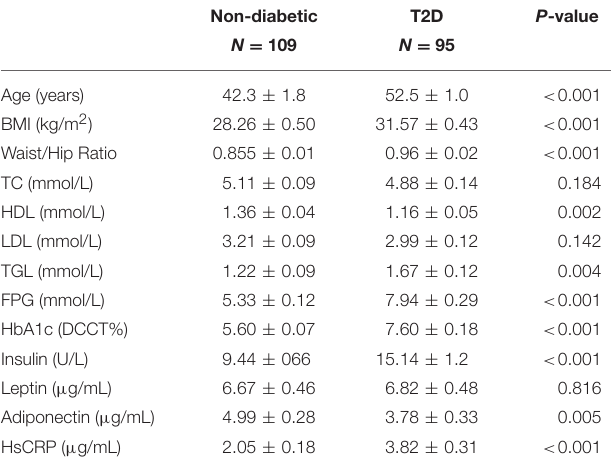
TABLE 3 | Demographics and characteristics of the subjects with